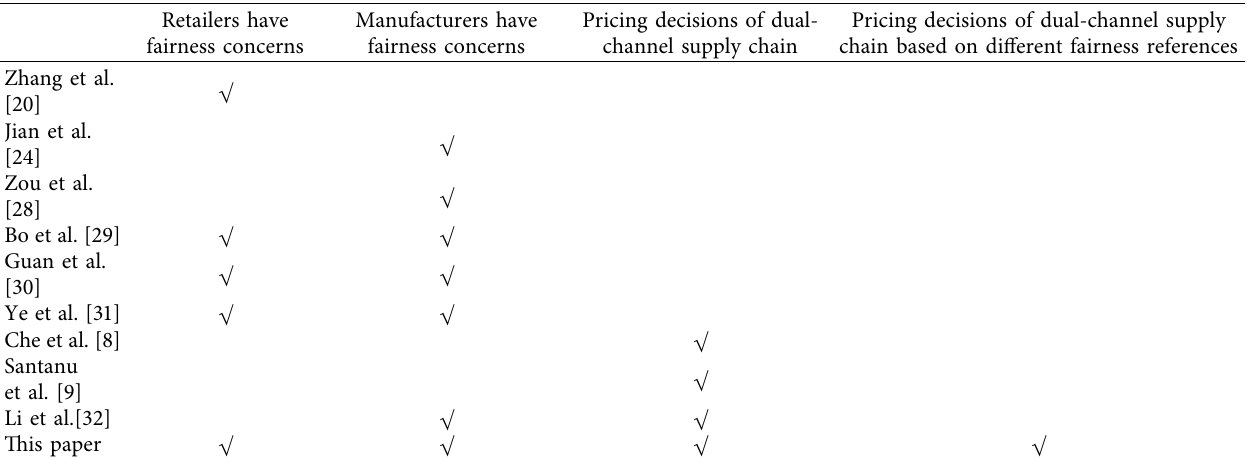
Table 1: Literature